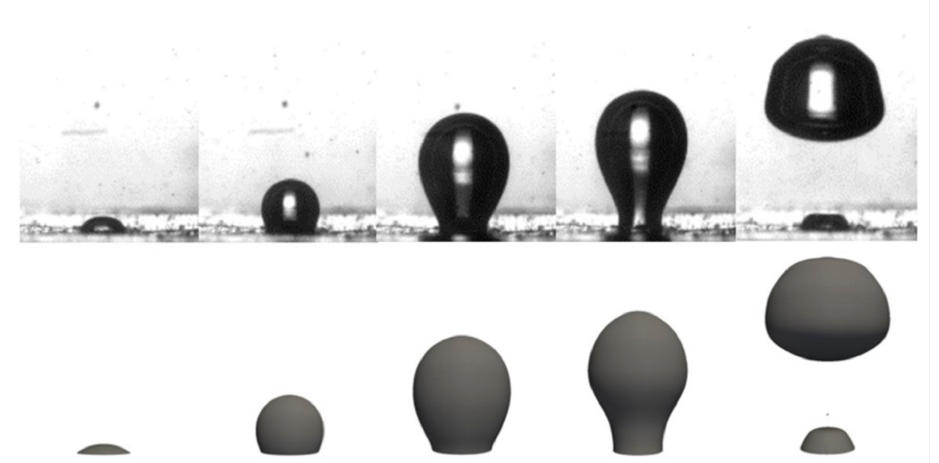
Figure 11. Comparison between experimental and numerical results to validate the model. The phases are water and water vapor, the superhydrophobic region diameter is 1.5 mm and the imposed heat flux is 1290 W/m 2